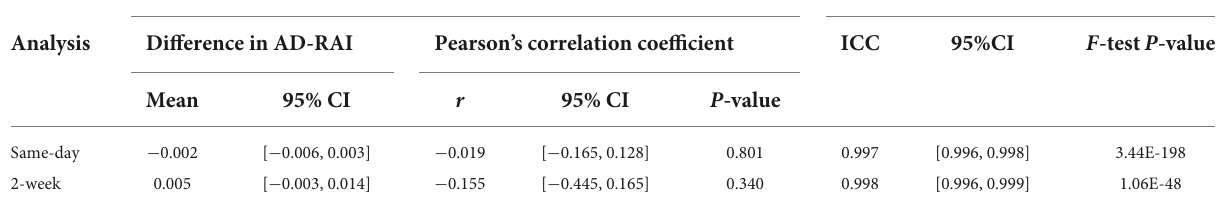
TABLE 2 Same-day repeatability and 2-week reproducibility analysis